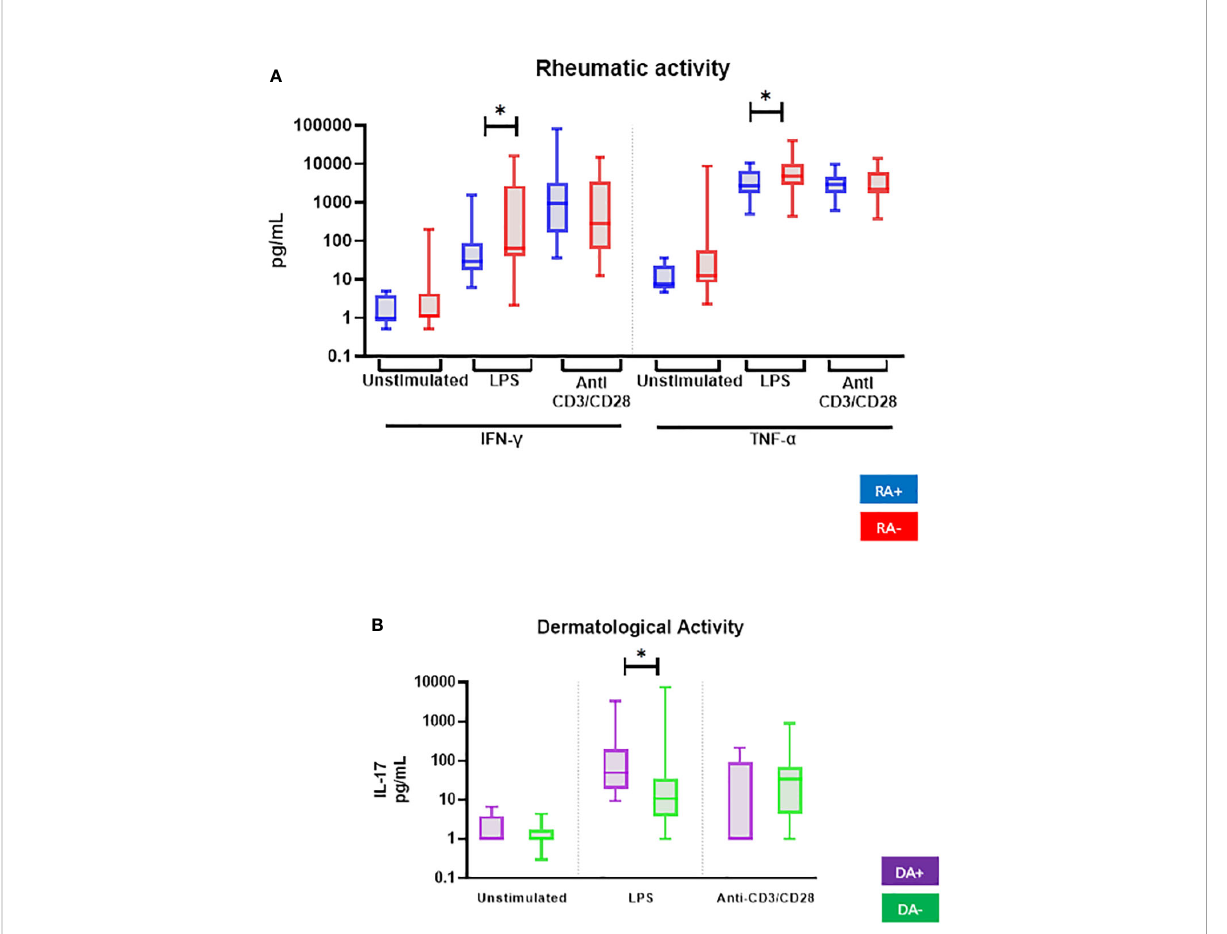
FIGURE 2 Comparison of ex vivo cytokine production of all PsD patients (n = 48) according to (A) their rheumatic (RA) and (B) dermatological (DA) disease activity. PBMCs from PsD patients (n = 48) were cultured at 1x10 6 cells/ml for 24 h at 37°C, 5% CO 2 with and without stimulation of monocytes by E. coli LPS (1 µg/mL) or T lymphocytes by anti-CD3/CD28 mAb (2.5 × 10 4 beads/10 6 cells/ml). Supernatants were collected and cytokine levels were assayed by Luminex Multiplex ELISA. Results are presented using median values with minimum to maximum box-plot. Difference between the groups using non-parametric Mann-Whitney U test is presented in the top of the fi gure for each condition. * p < 0.05. RA, Rheumatic activity (n RA+ = 10); DA, Dermatological activity (n DA+ =